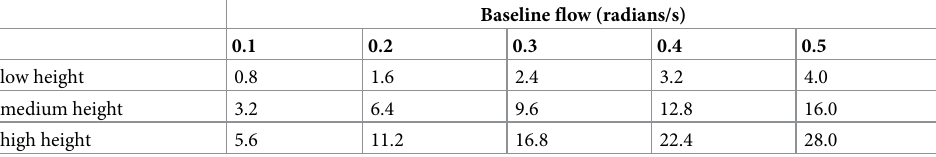
Table 1. Stimulus speeds (mm/s) for the baseline flow